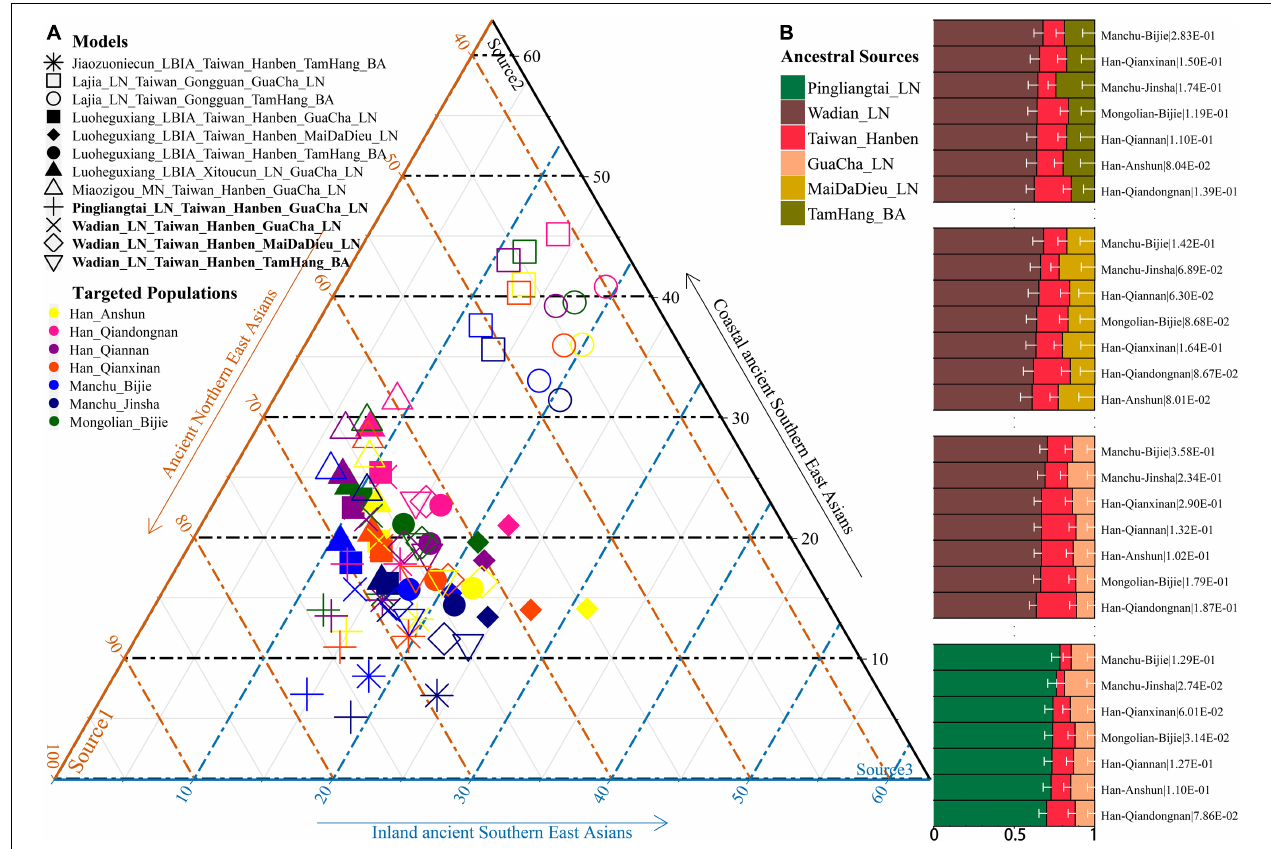
FIGURE 4 | Three-way admixture models for seven Guizhou populations. (A) Variable ancestry proportion of three ancestral sources under the 12 fitted admixture models. (B) Histogram showed the major ancestry of Guizhou populations derived from the Yellow River farmers. White bar denoted the standard errors of the ancestry proportion. p -values of the tests were labeled behind the population